Question: Name the type of graph shown.
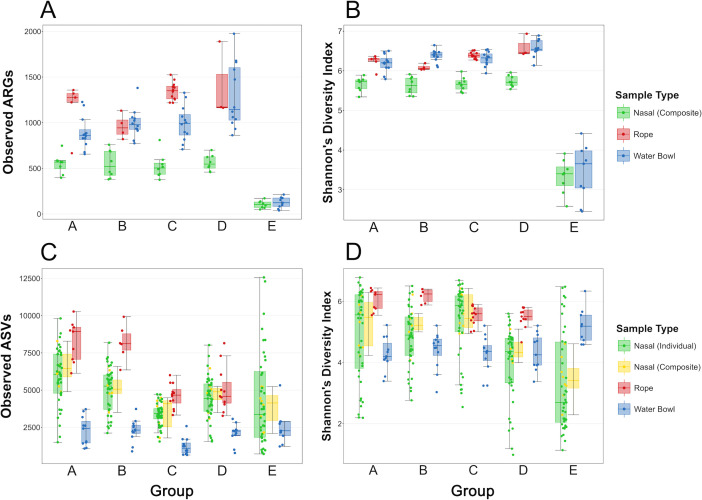
Answer: box